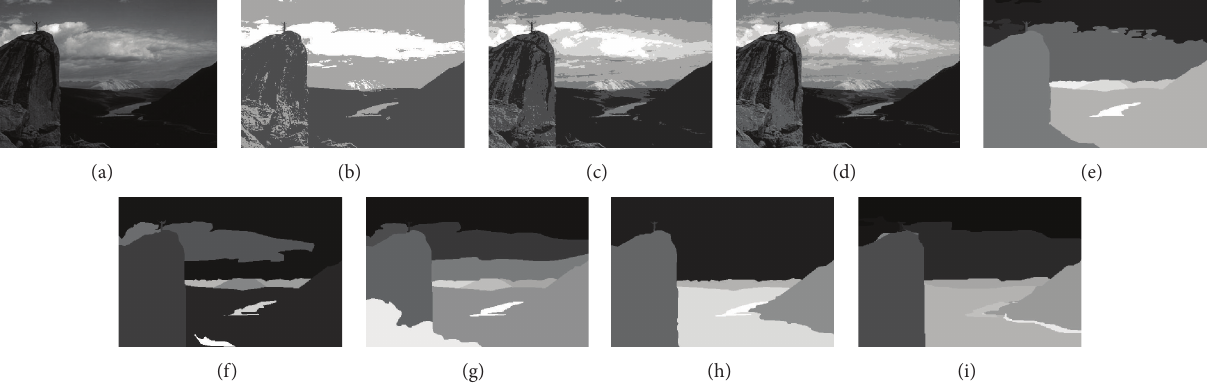
Figure 9: (a) Original image 14037, (b) M − 1 = 2 PRI = 0.73621 , (c) M − 1 = 5 PRI = 0.79629 , (d) M − 1 = 9 PRI = 0.80293 , (e)–(i) the ground-truth hand segmentations offered by Berkeley Segmentation